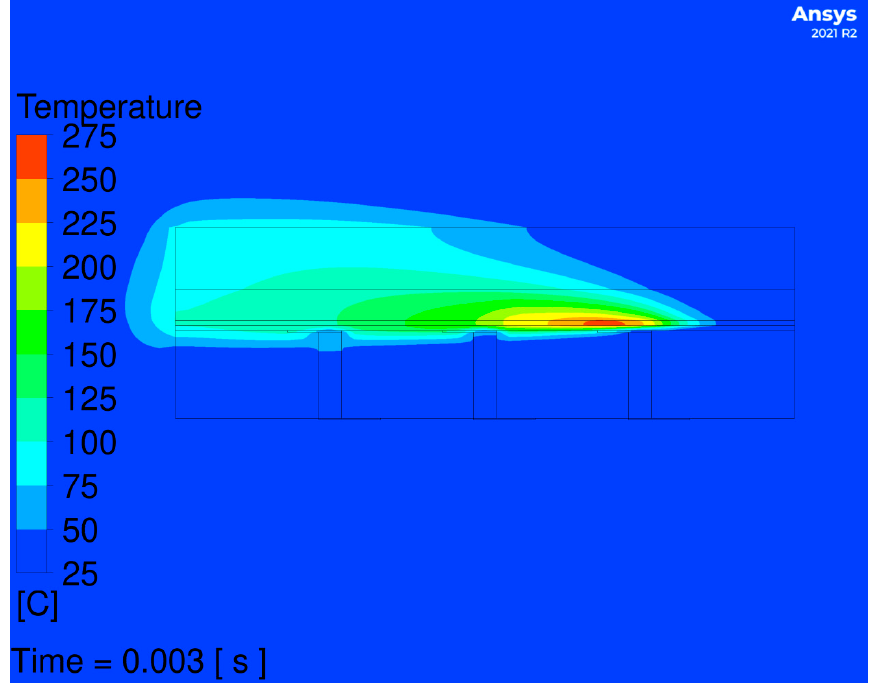
Figure 9. Temperature contours after 3 ms.